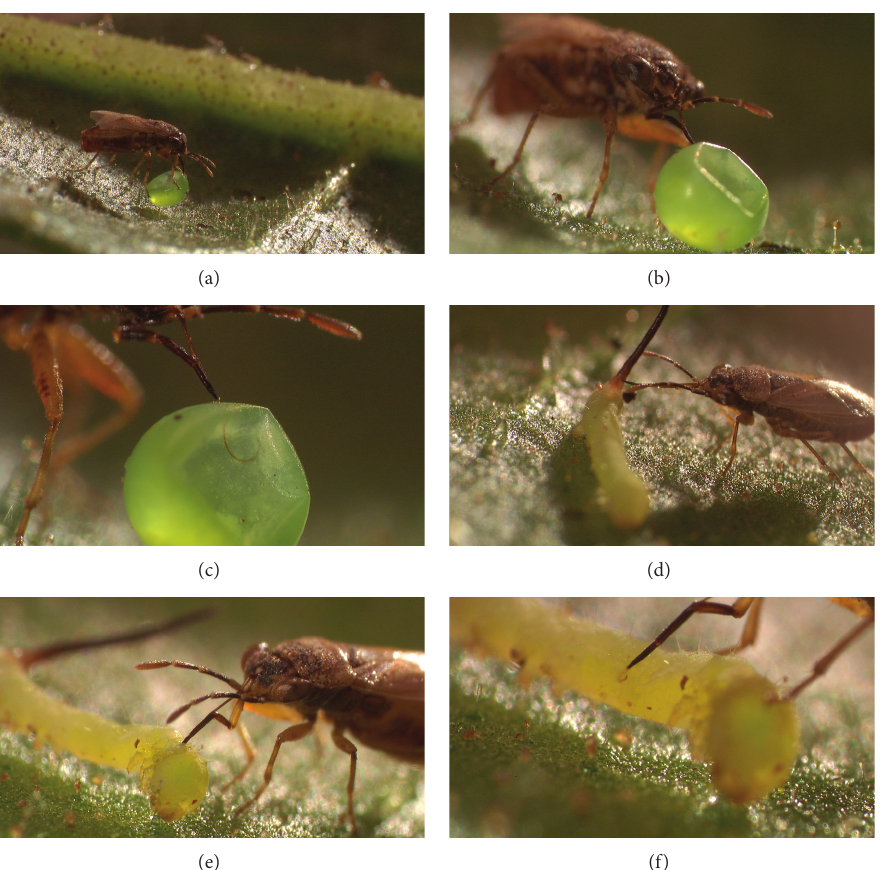
Figure 4: G. pallens feeding on a Manduca sexta egg (a)–(c) or larva (d)–(f). Note the flexible stylet clearly visible inside the egg in (c). Copyright: Merit Motion Pictures, Winnipeg, MB, Canada.